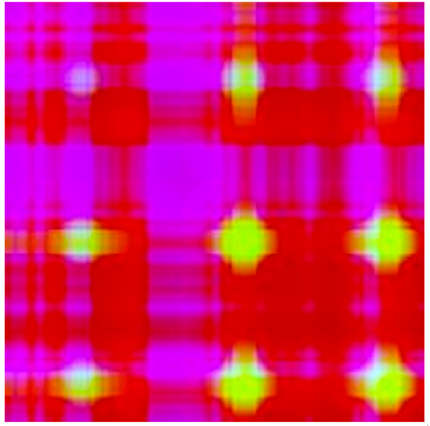
9 Figure 7. Comparison between cross helmet and racing helmet. Figure 8. Overlapping GASF matrices.